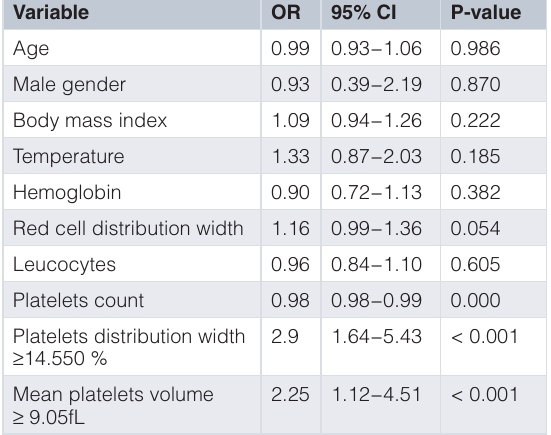
Table 5. Comparing the median (IQR) blood parameters in patients with P. falciparum and P. vivax malaria. Data is displayed as mean (±SD), and the t-test was used because the data was normally